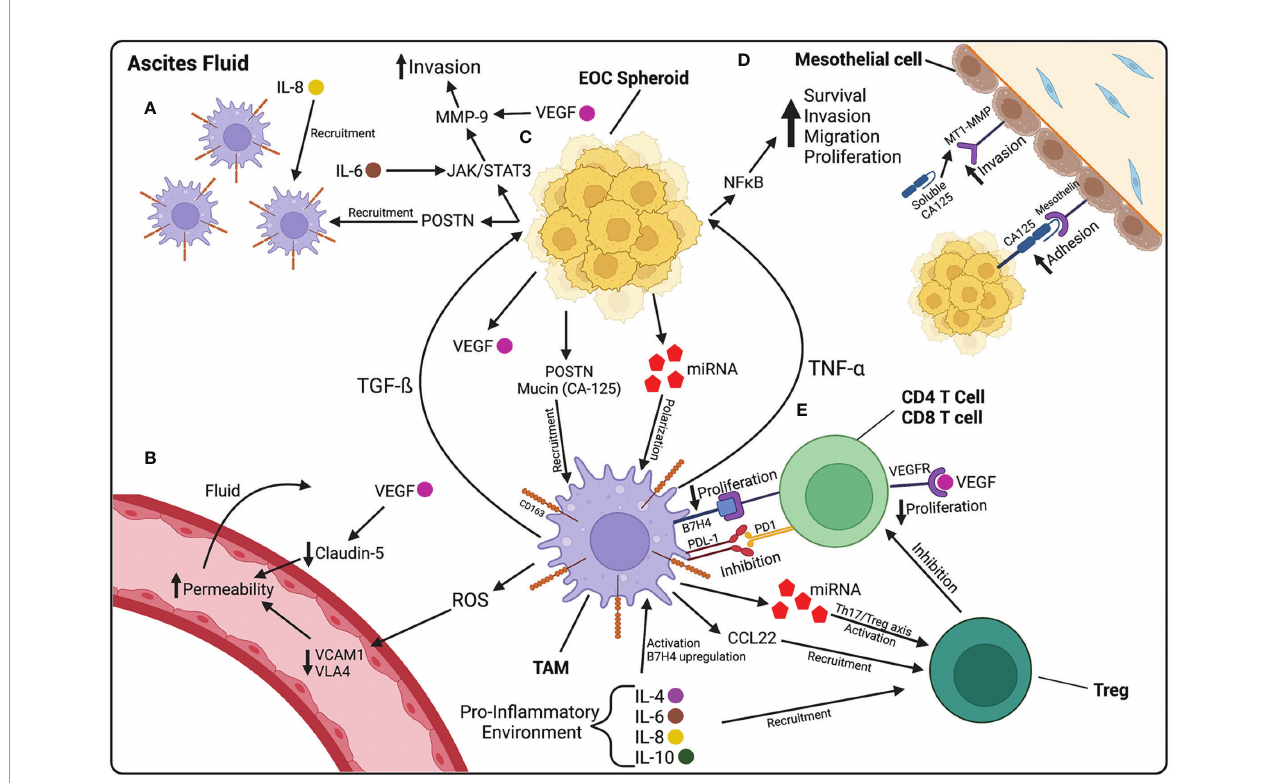
FIGURE 2 | The ascites fl uid is composed of cellular and non-cellular components that contribute to the progression of EOC. (A) Macrophages are recruited to the peritoneal cavity by IL-8, found at high levels in ascites fl uid, and POSTN, released by EOC cells. (B) Increased vascular permeability contributes to the accumulation of fl uid within the peritoneal cavity. ROS released by macrophages decreases VCAM1 and VLA4, leading to increased permeability. VEGF, released by HGSOC cells, also contributes to increased permeability by decreasing the junctional protein Claudin-5 between endothelial cells. (C) EOC spheroids fl oating in ascites release POSTN and mucins, involved in macrophage recruitment, and miRNA-containing exosomes that polarize macrophages towards a TAM phenotype. TAMs then release TGF- b which activates further POSTN release and the JAK/STAT3 pathway in HGSOC cells, involved in increasing invasion capabilities through MMP-9 activation. TAMs also release TNF- a which activates the NF- k B pathway, involved in increasing the survival, proliferation, migration, and invasion of EOC cells. (D) CA125 on the surface of EOC cells plays a role in the adhesion of cancer cells to the mesothelium by binding to mesothelin on the surface of mesothelial cells. CA125 is also found in a soluble form in ascites fl uid and increases the expression of MT1-MMP on mesothelial cells, leading to increased invasion of EOC cells. (E) TAMs play a role in suppressing the immune system in ascites fl uid. Pro-in fl ammatory cytokines in ascites upregulate B7H4 receptor on TAMs. B7H4 binds to T cells and decreases their proliferation. TAMs also release CCL22, that recruit Tregs, and miRNA containing exosomes, that activate Tregs. Created with